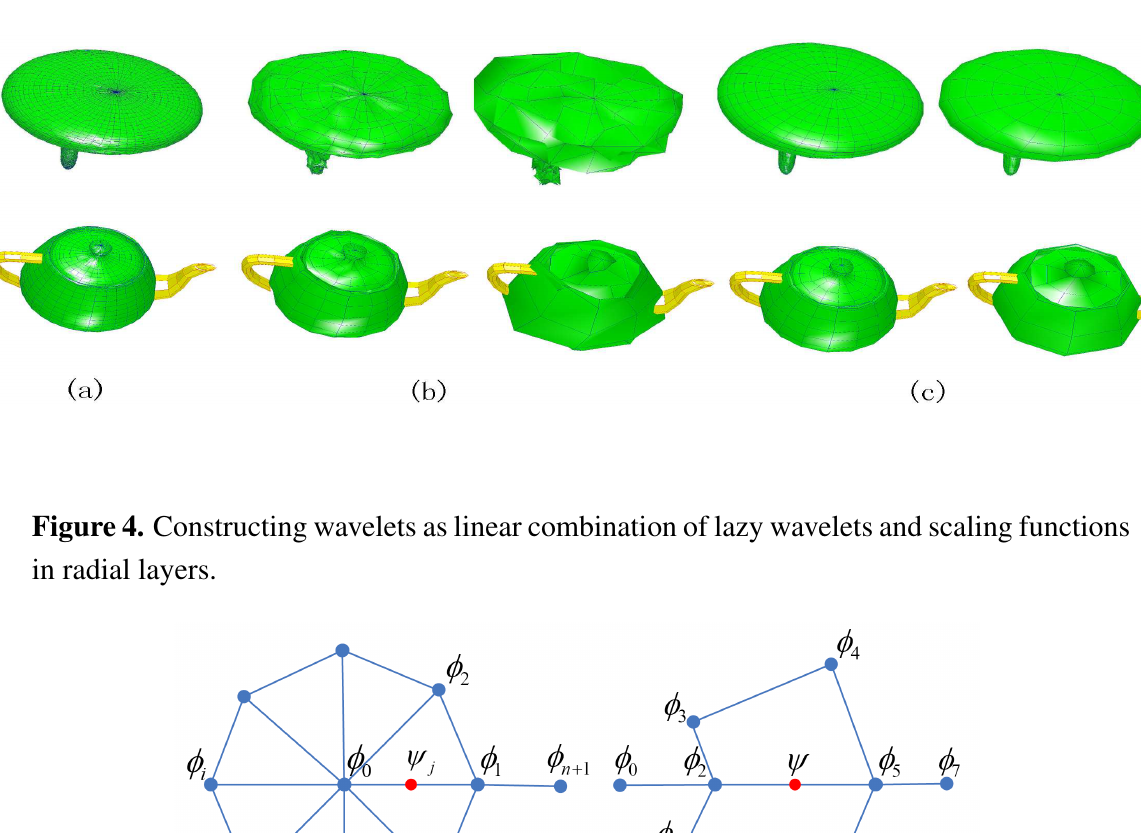
Figure 3. (a) original surfaces perturbed with white noise; (b) the surfaces performed lazy wavelet analysis once and twice; (c) the surfaces performed our scheme once and twice.